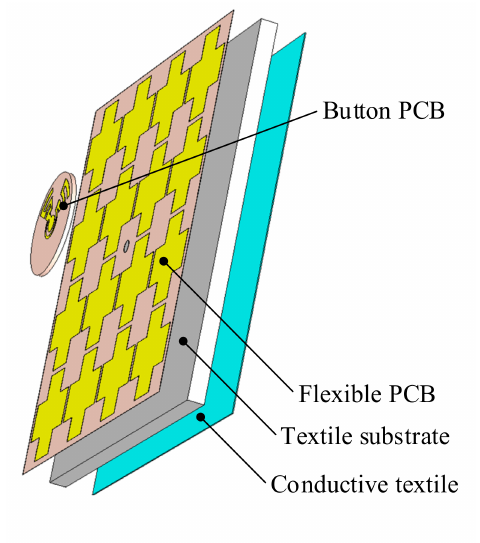
Figure 4. Exploded view of the proposed antenna